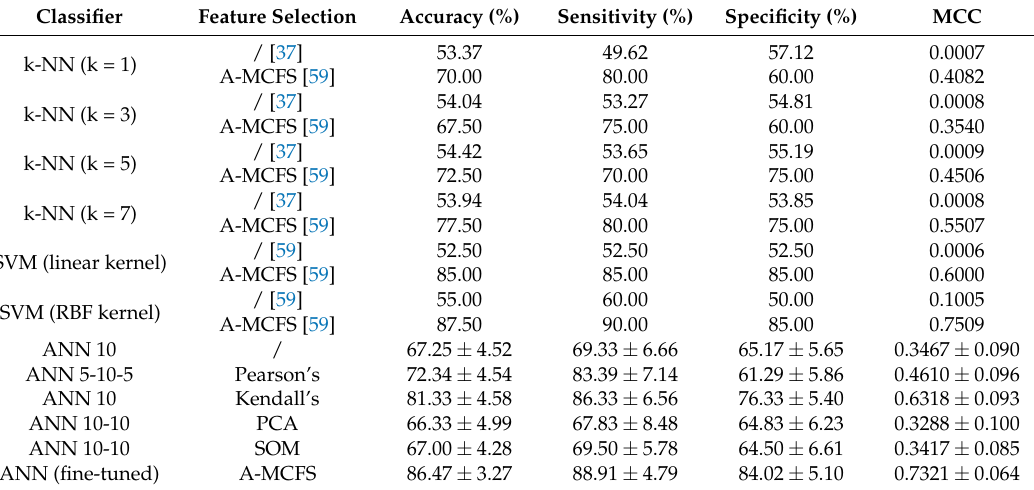
Table 6. Comparison of different classifiers performance on PD